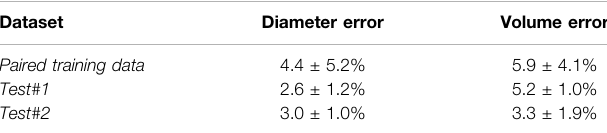
TABLE 4 | Biological evaluation for left atrium reconstruction from point clouds in the 300 generated ( Paired training ), 4 clinical MRI ( Test #1 ), and 2 clinical CT ( Test #2 )